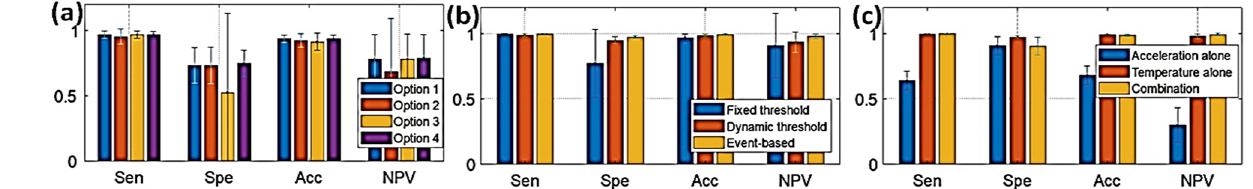
Figure 7 . The mean and standard deviation of the sensitivity, specificity, accuracy, and NPV for the different algorithms. Panel ( a ) compares the performance of the four options of the event- and temperature-based algorithms; panel ( b ) compares the performance of window-based fixed and dynamic thresholds and event-based temperature algorithms; panel ( c ) compares the performance of algorithms based uniquely on the accelerometer, the temperature (event-based), or a combination of the two sensors.